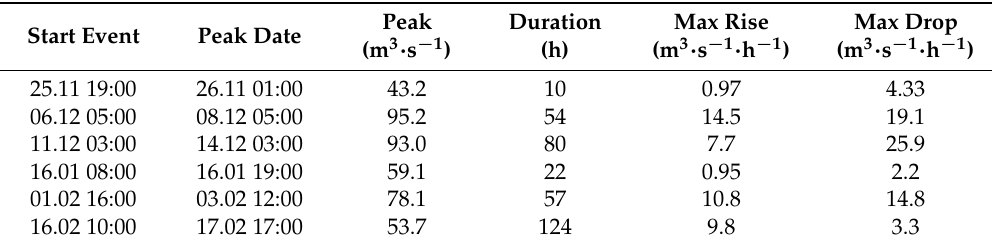
Table 3. Summary of characteristic data for the event shown in Figure 2. A threshold of 10 m 3 · s − 1 is used, and only events with a duration of more than 5 h are shown in the table.